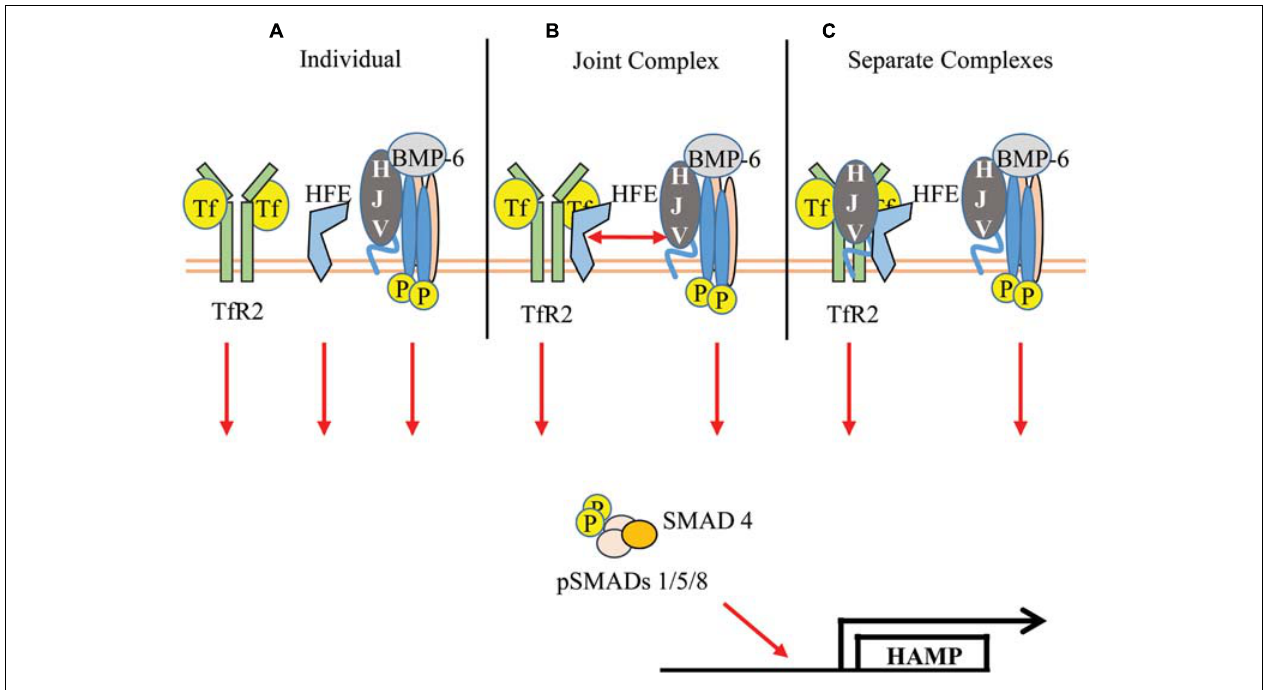
complex betweenTfR2/HFE/HJV/BMPR’s to enhance pSMAD. (C) Separate complexes composed ofTf/TfR2/HFE/HJV and HJV/BMP-6/BMPR’s signal to enhance